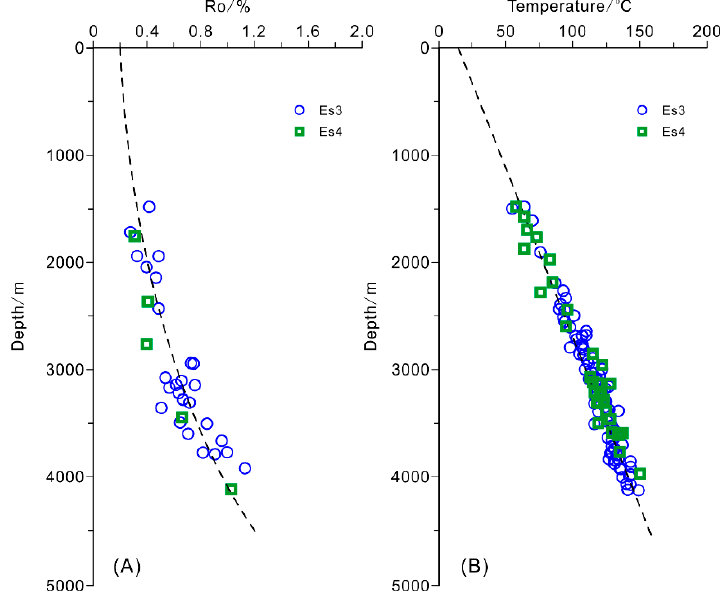
Figure 13. ( A ) Measured vitrinite reflectance (Ro, %) versus depth, which shows an exponential increase in Ro with depth. ( B ) Temperature versus depth in the Linnan Sag.